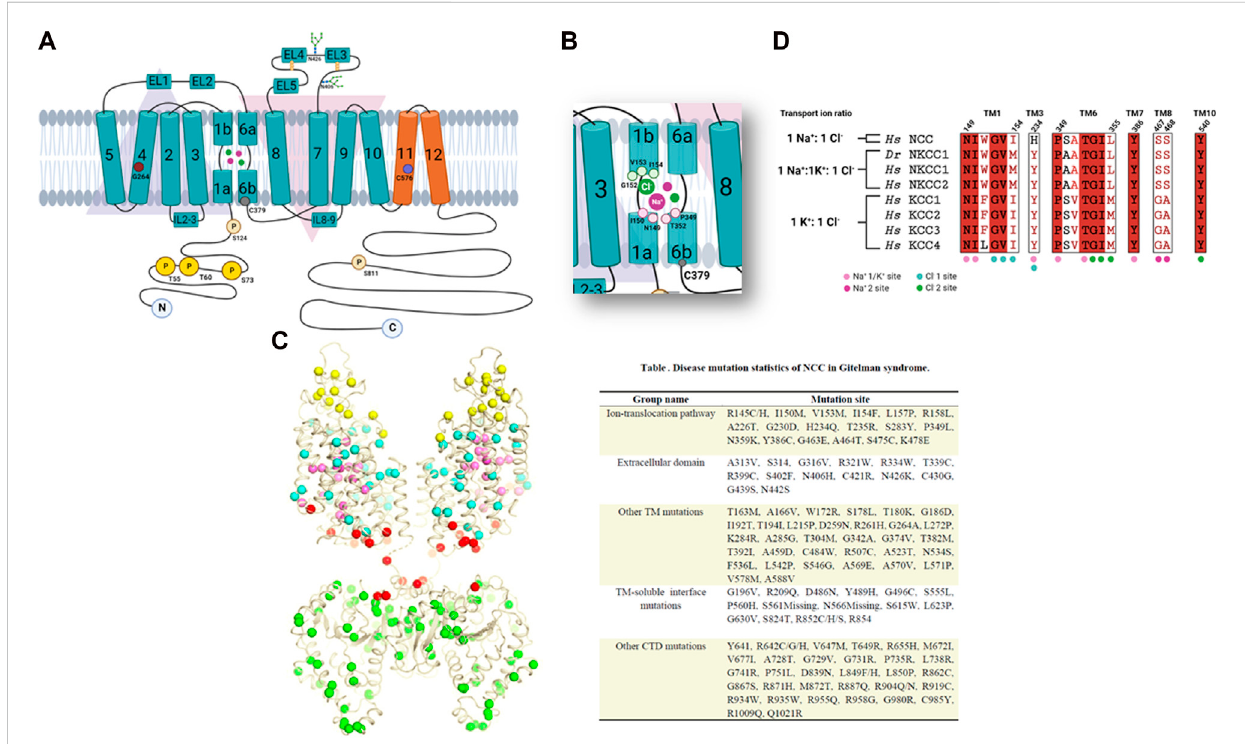
FIGURE 2 (A) TopologymapoftheNCC.TheinvertedarrangementoftheTM1-5andTM6-10domainscanbeseeninblueandtheTM11andTM12domainsin orange. An extracellular loop with glycosylation sites is observed between the TM7-8 domains. Different amino acids linked to NCC function are also shown. (B) Magni fi ed view of the TM1 and TM6 regions with the amino acids involved in ion binding. (C) Gitelman syndrome-linked mutations plotted ontothecryo-EMstructureofNCC,shownascoloredspheresdependingontheirlocation.Alsogroupedbylocationinthetablewiththeiridenti fi ed mutation site. (D) Amino acid sequence alignments analysis of the ion binding sites in human CCCs. Copied from Nan et al. (2022), supplemented with details from studies done by Pacheco-Alvarezet al. (2006), Moreno etal. (2004), Moreno etal. (2006), Moreno et al. (2016), Moreno etal. (2022), Monroy et al. (2000), Castañeda-Bueno et al. (2010), Tutakhel et al. (2018). Created by